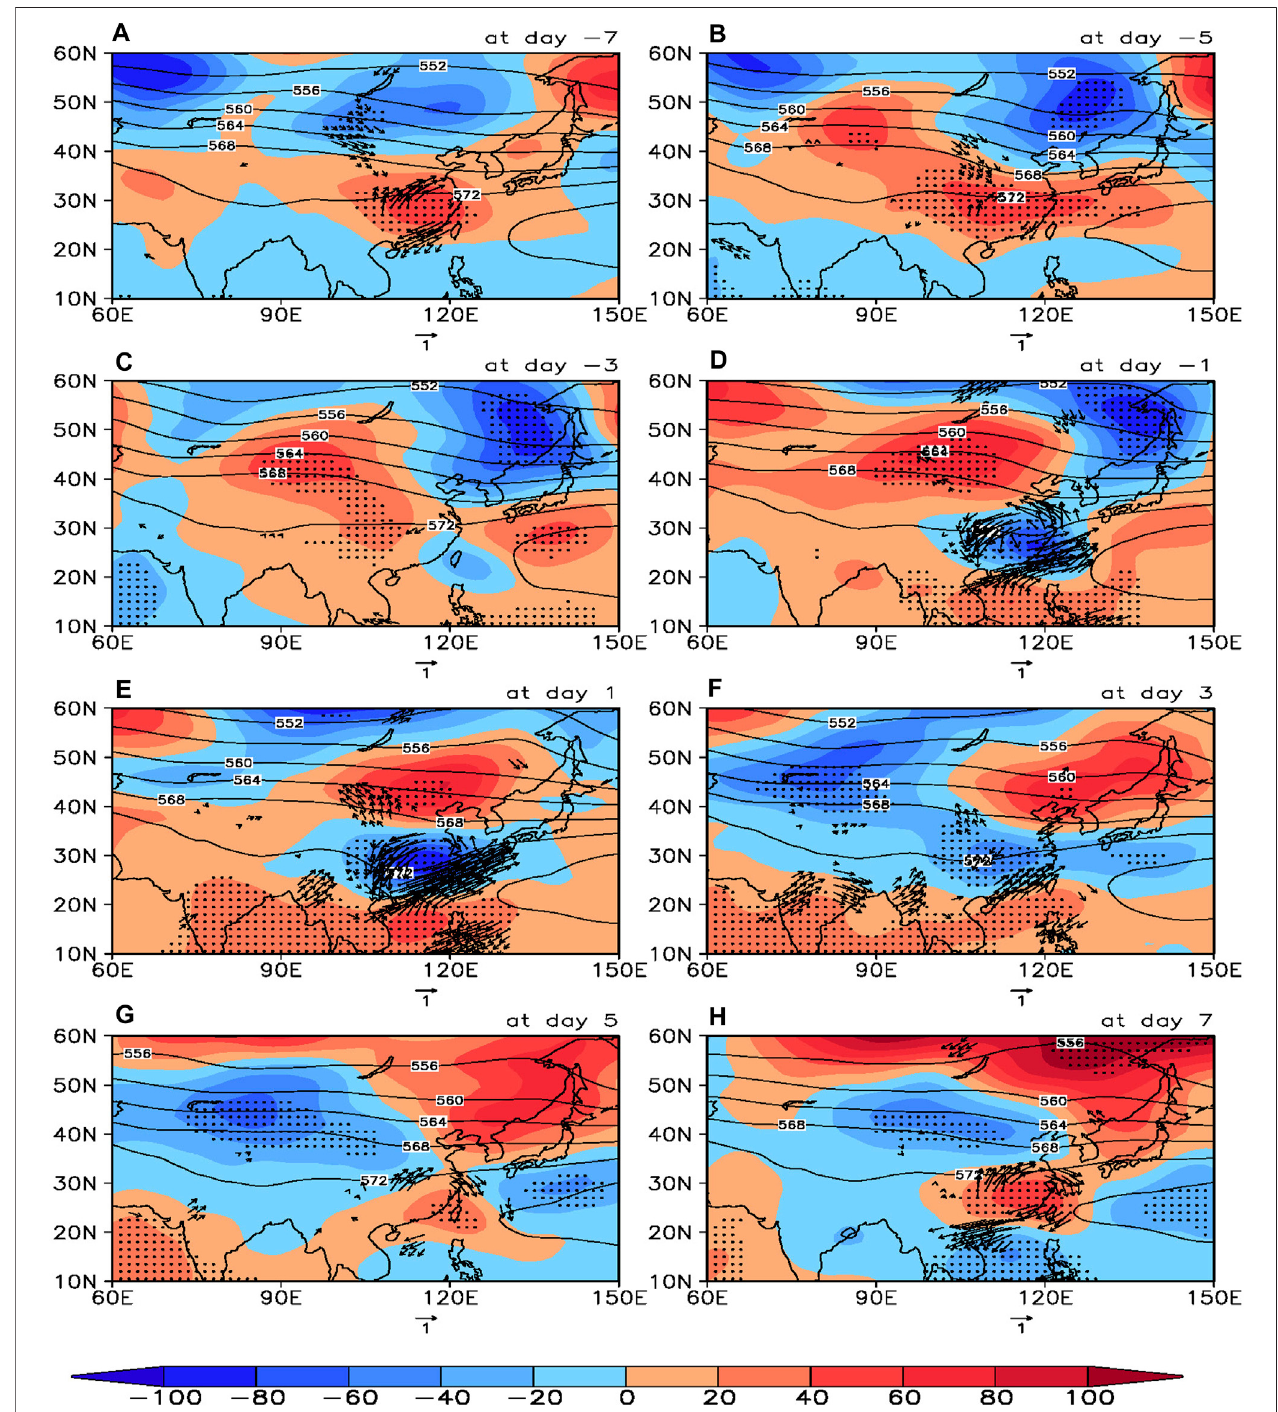
FIGURE5| Composite distribution ofgeopotentialheight(contoured,unit: dagpm), 10-to30-day fi lteredgeopotentialheight(colorshaded,unit: gpm)at500 hPa andthe10-to30-day fi lteredwindat850 hPa(vector,unit:m/s;onlylocallystatisticallysigni fi cant( > 95%)vectorsareshown)duringtherainfallQBWOevents,thedotted area indicates that it has passed the 95% con fi dence test. (A – H) represent day -7 to day 7, with 2-day interval.